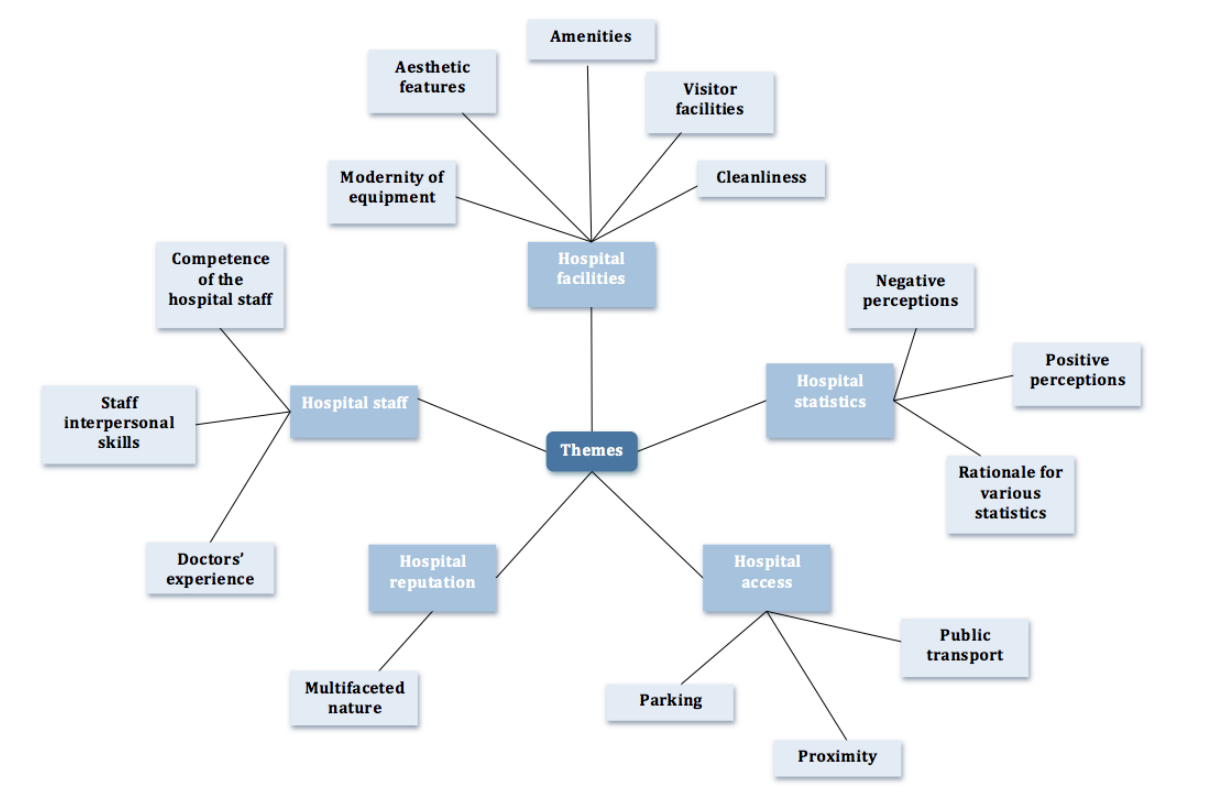
Figure 2. Thematic map of qualitative data from focus